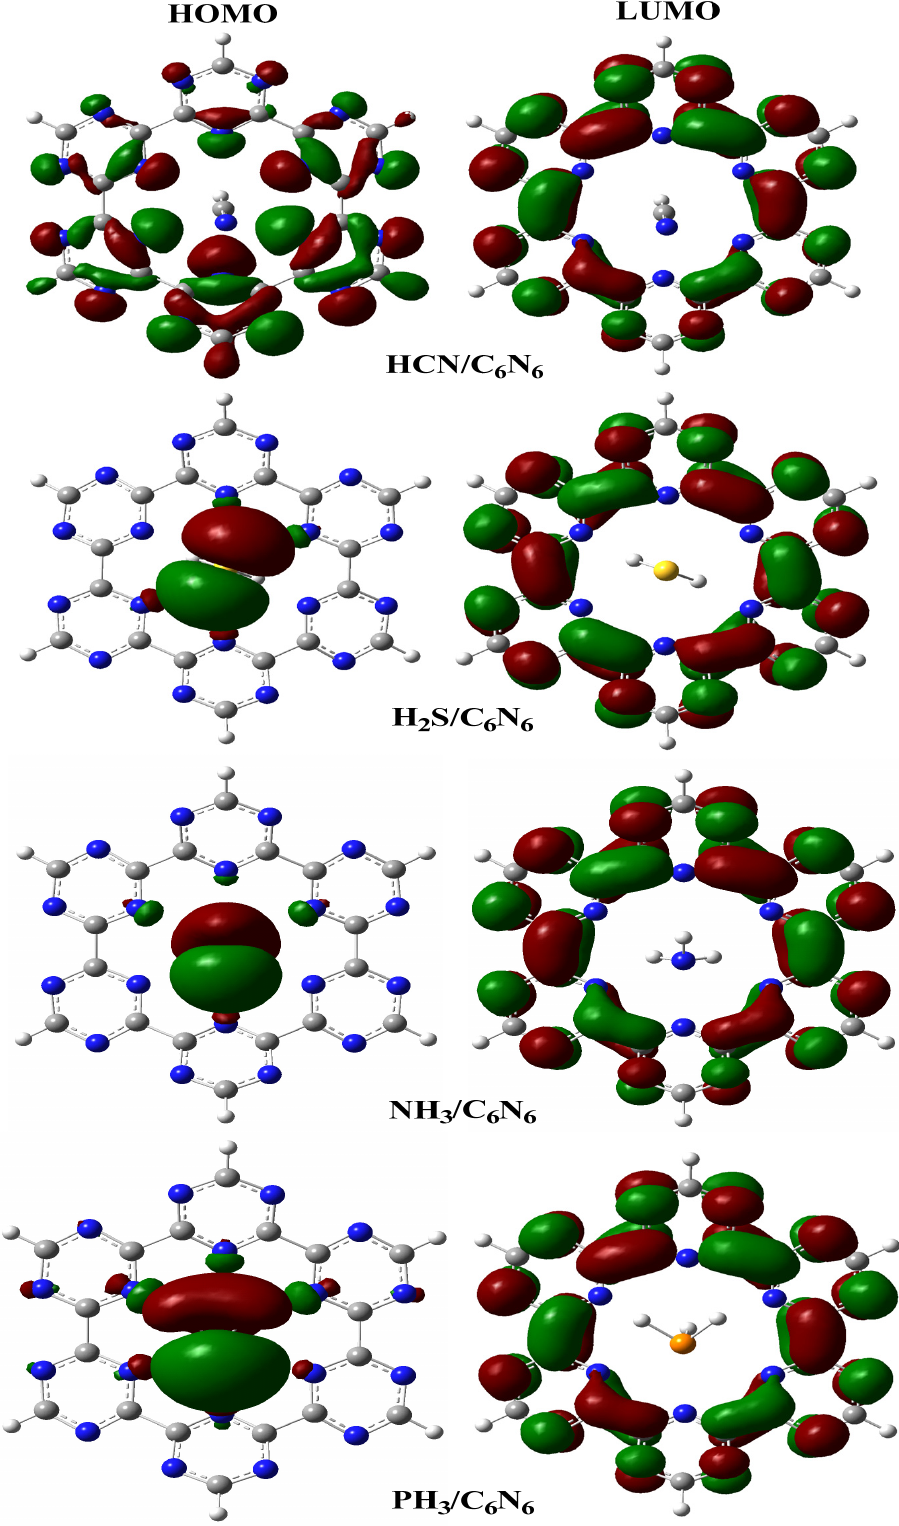
Figure 7. Orbital distribution pattern of analyte@C 6 N 6 complexes computed through a FMO analysis (isovalue = 0.02 a.u.). Green orbital densities indicate a positive wavefunction, while red orbital densities show a negative wavefunction.